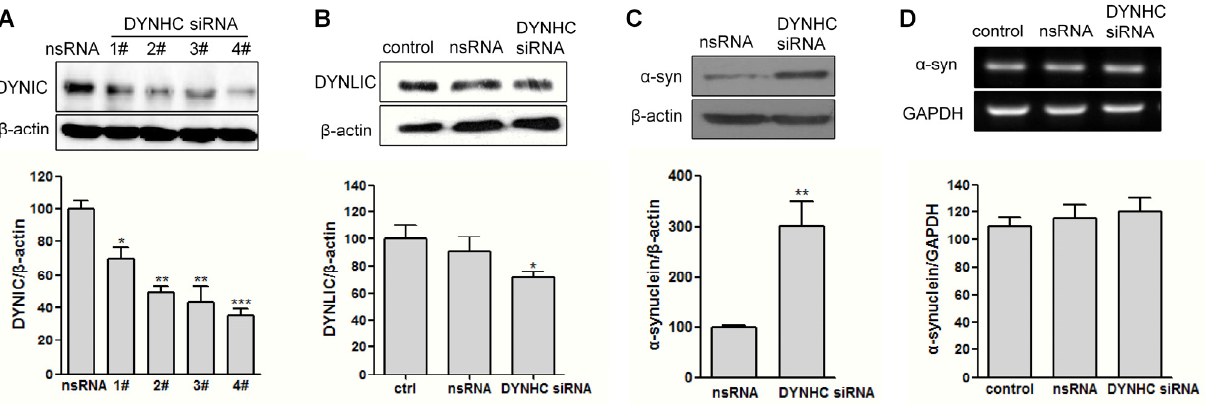
Figure 2. The clearance of mutant α -synuclein A53T is impaired in dynein knocked down cells. ( A , B ) A53T stably expressing PC12 cells were transfected with siRNAs against DYNHC or scrambled RNA (nsRNA). The knockdown efficiency was determined by western blotting at 48 h after transfection; ( C , D ) The α -synuclein ( α -syn) protein expression and its mRNA level were determined at 48 h after transfection; and ( E , F ) 1 μ g/mL CHX was added into the culture medium for up to 24 h to inhibit protein biosynthesis after siRNA transfection. Cells were harvested and lysed at 0, 3, 6, 12, and 24 h after CHX treatment. The protein degradation rate is expressed as half-life ( t degradation of 50% of α -synuclein protein. Data represent mean ± SEM, n = 3, * p < 0.05; ** p < 0.01; *** p < 0.001 versus the indicated control